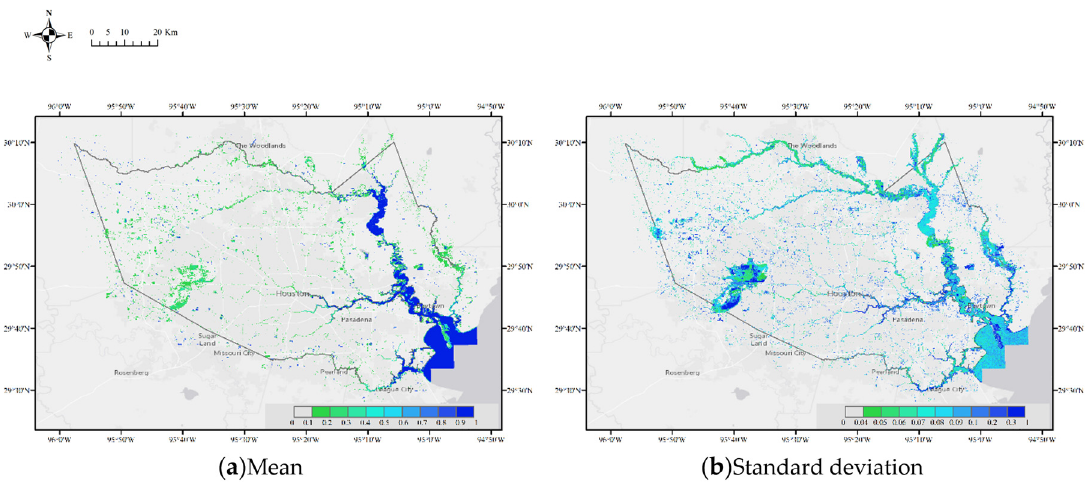
Figure 18. ( a , b ) The mean and standard deviation of inundation probability from 17 August to 5 September when data are available.